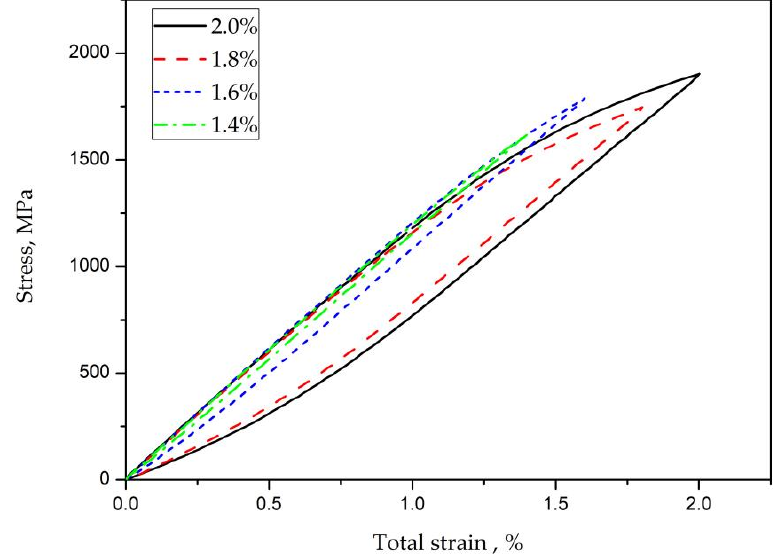
Figure 7. The superimposed hysteresis loops along the linear portion to match upper branch for TC21 alloy.